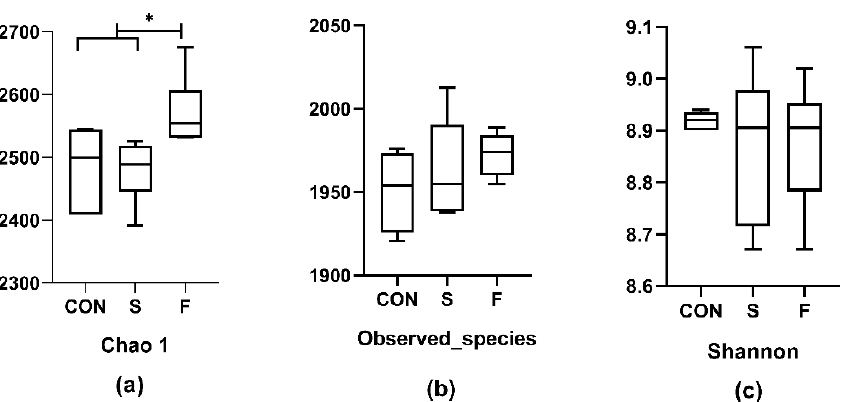
Figure 4. Alpha diversity indices for the sample bacterial communities. CON: Control group, S: Raw whole soybean treated group, F: Flaxseed treated group. ( a ): Richness of Chao 1 index, ( b ): Number of observed species, ( c ): Diversity estimator of Shannon. *: p < 0.05. Data are shown as the mean ± SEM, n = 6.